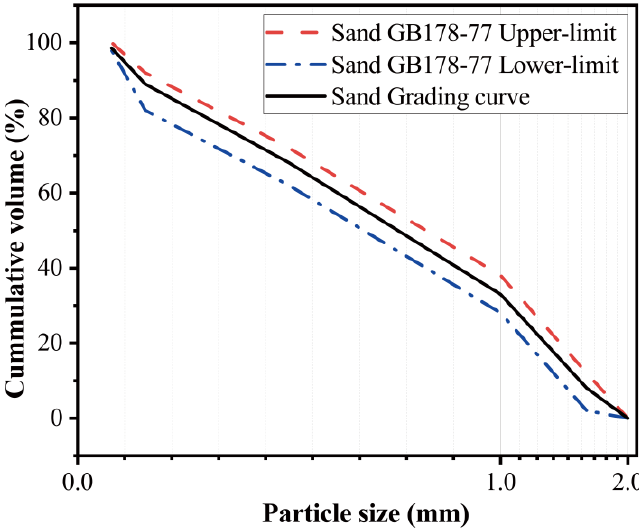
Figure 4. Standard sand particle size.